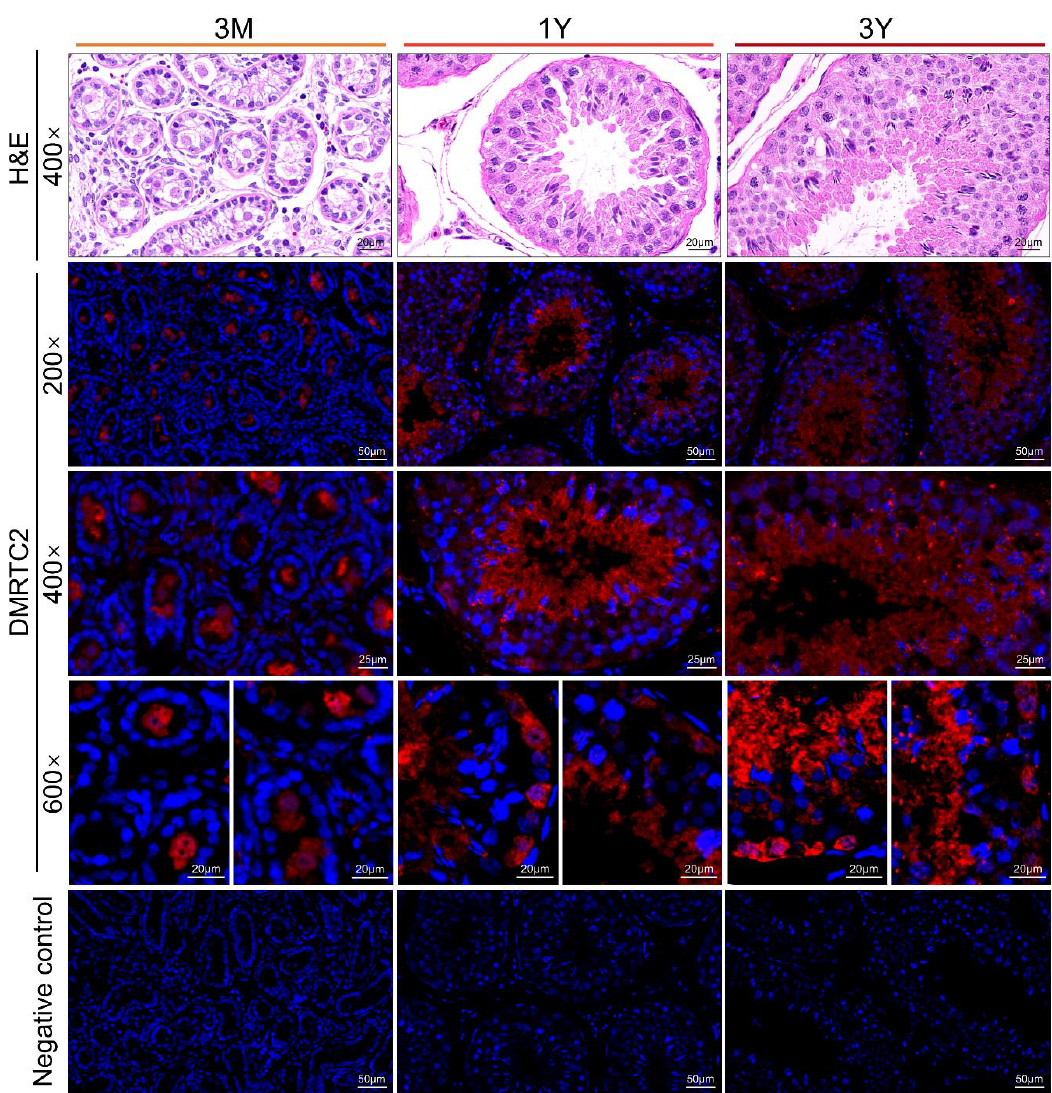
Figure 7. Hematoxylin and eosin (H&E) staining and immunofluorescence staining of DMRTC2 protein within Tibetan sheep testes at different development stages. Nuclei were counterstained with DAPI (blue). 3 M: three months old, 1 Y: one year old, and 3 Y: three years old.